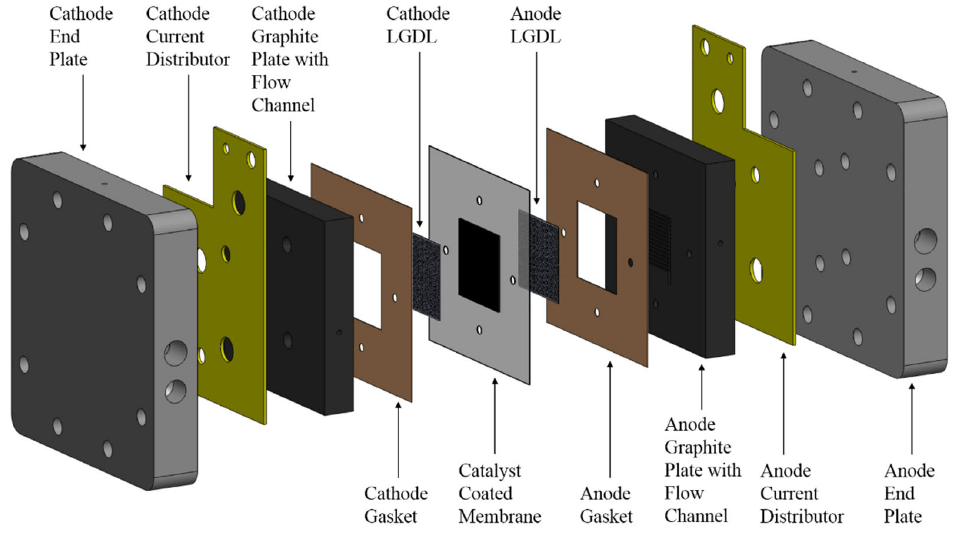
Figure 1. Schematic diagram of a standard PEM water electrolyzer.